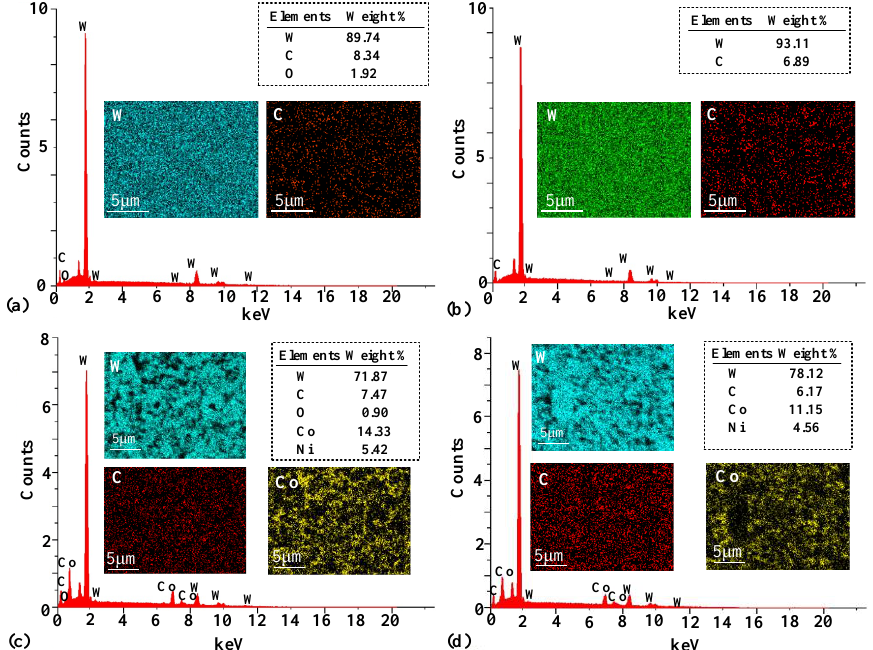
Figure 8. EDS analysis results. ( a ) WC-0Co before polishing; ( b ) WC-0Co after fine polishing; ( c ) WC-12Co before polishing; ( d ) WC-12Co after fine polishing.